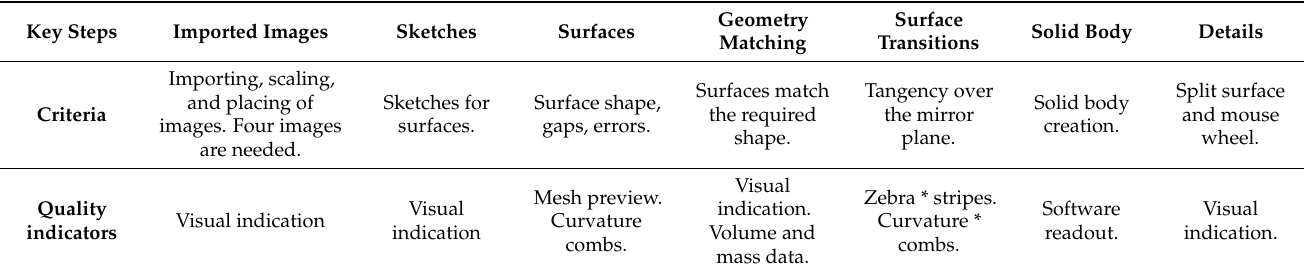
Table 1. Criteria and quality indicators of identified key modelling